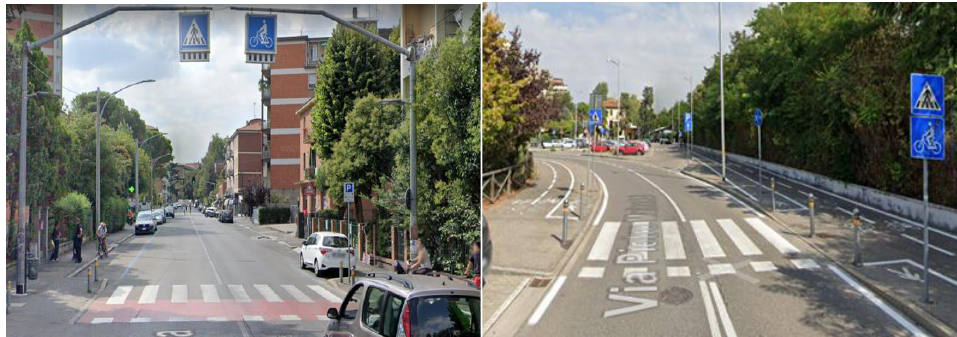
Figure 2. Crossing “ I1 ” along Azzurra street (on the left ) and crossing “ I2 ” along Mainoldi street (on the right ).